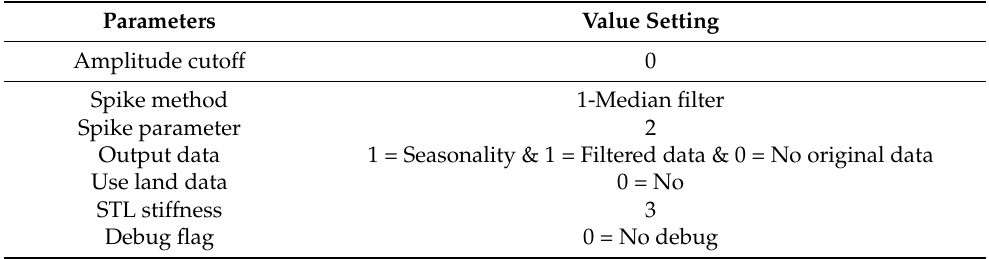
Table 1. Common parameter settings used in this study for NDVI smoothing using the TIMESAT